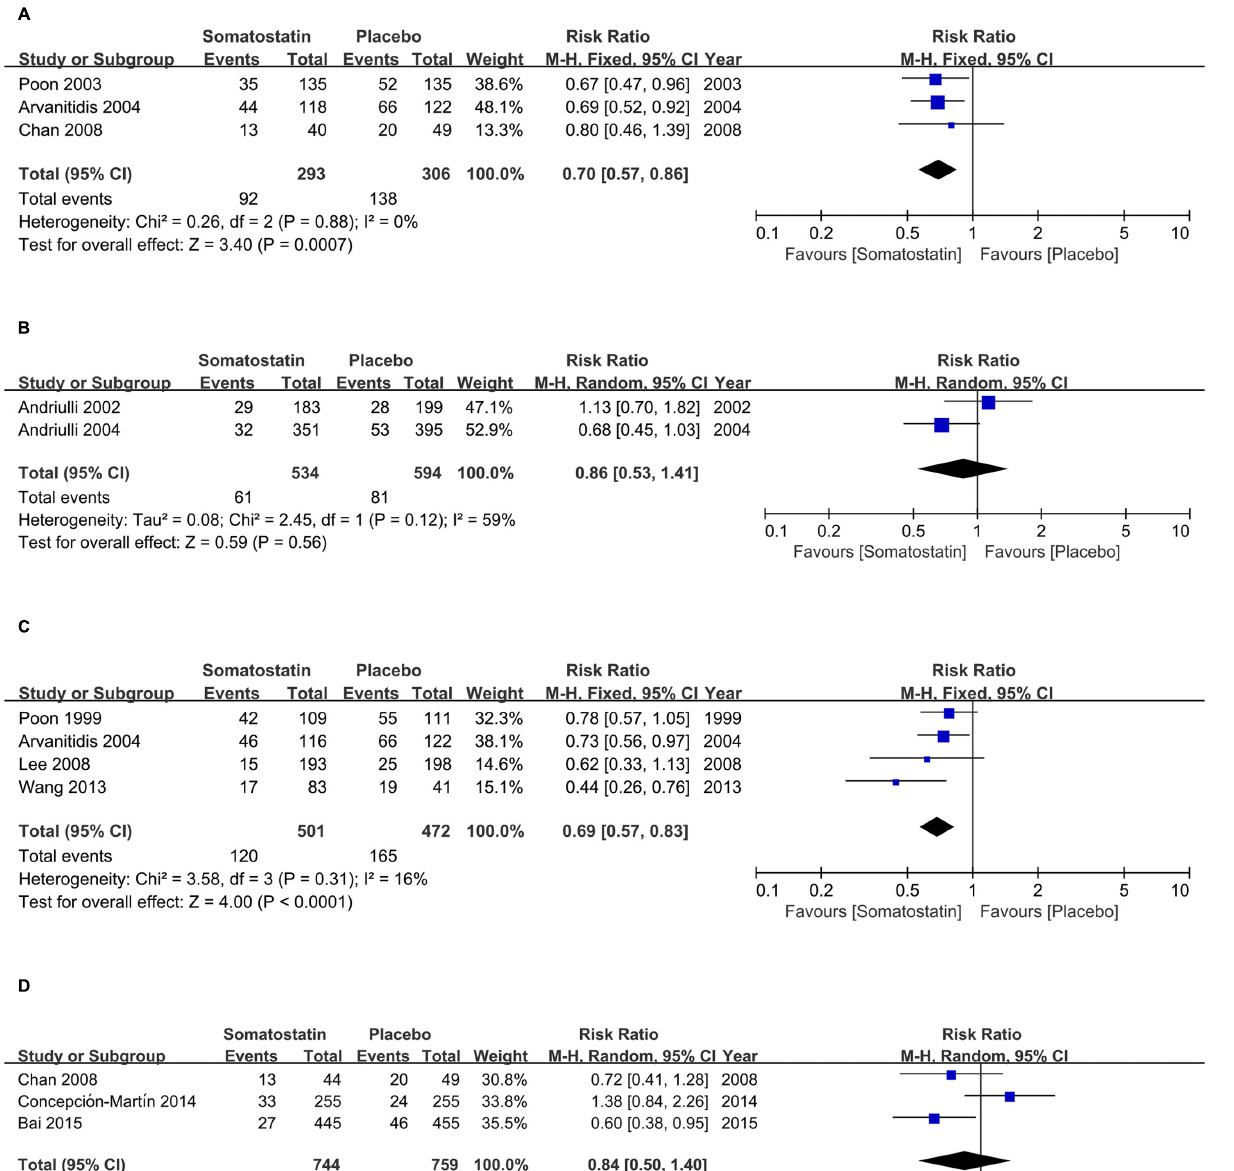
FIGURE 6 | Forest plot of RR of ERCP-induced hyperamylasemia in patients treated with SOM as single bolus (A) , short-term infusion (B) , long-term infusion (C) , and bolus plus continuous infusion (D) . I 2 and P is the criterion of heterogeneity test, (cid:7) pooled risk ratio, — (cid:4) — risk ratio and 95% CI.